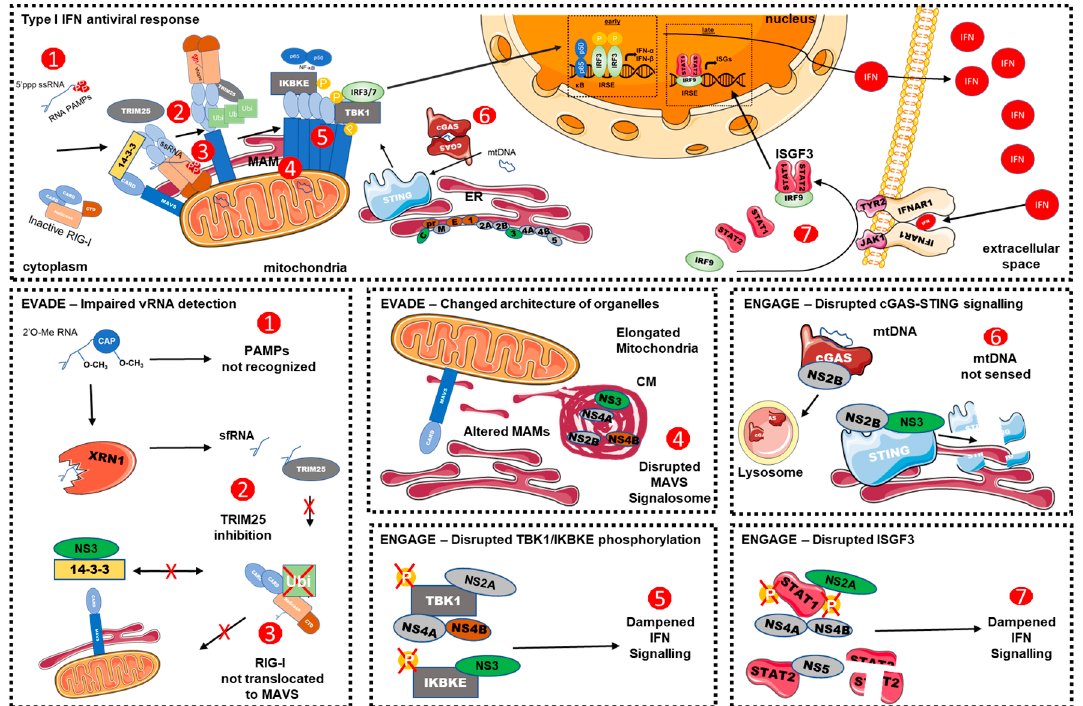
Figure 1. The sensing of Dengue virus by the innate immune responses and multiple evasion strategies to hinder the production of type I interferons (IFN).The upper panel shows the sensing of viral infection by RIG-I and cGAS. DENV-derived PAMPs are recognized by various pathogen recognition receptors like RIG-I. Upon recognition of pathogenic RNA, RIG-I is translocated to the mitochondria-associated MAVS adaptor protein with the help of the 14-3-3 and TRIM25 proteins. This induces the formation of MAVS aggregates that serve as an immune signalosome to activate through phosphorylation transcription factors IRF3 and NF- κ B. In turn, these transcription factors translocate to the nucleus and elicit the transactivation of type I IFN. Once produced, type I IFN is secreted into the extracellular space and activates, in paracrine and autocrine fashions, the JAK-STAT pathway, leading to the amplification of the antiviral response via the activation of STAT1, STAT2, and IRF9, a transcription factor complex known as ISGF3. Infection also leads to mitochondrial stress and the release of mtDNA into the cytosol. mtDNA is recognized by cGAS, which activates STING, leading to the activation of IRF3 / NF- κ B and IFN production. DENV has developed various countermeasures to evade and / or engage the RLR and cGAS / STING pathways and to hinder innate immune signalling. These evasion mechanisms include ( 1 ) posttranscriptional modification of vRNA; ( 2 ) inhibition of 14-3-3 ε or TRIM25 to hinder RIG-I activation; ( 3 ) MAVS aggregation; ( 4 ) alterations in endomembrane architecture to disrupt the MAVS signalosome; ( 5 ) the inhibition of TBK1 and IKBKE kinase activation, preventing the activation of transcription factors like IRF3; ( 6 ) the disruption of cGAS / STING signalling; and ( 7 ) the